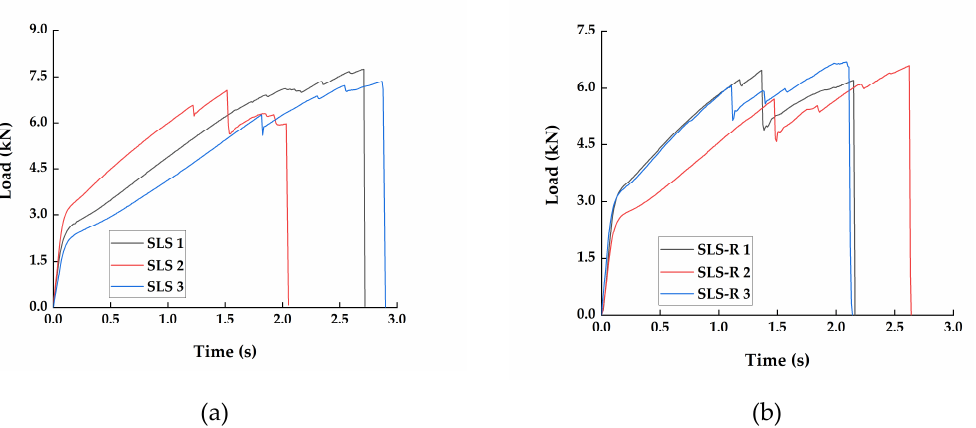
Figure 4. Load response plotted over time for the ( a ) SLS Specimens SLS 1, SLS 2 and SLS 3 and ( b ) SLS-R Specimens SLS-R 1, SLS-R 2 and SLS-R 3.